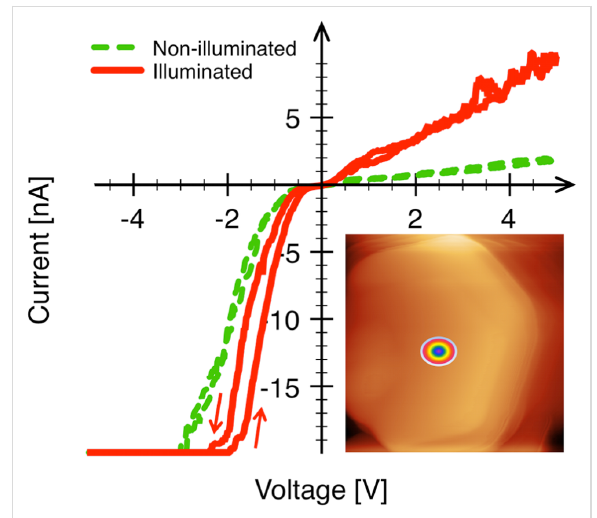
Figure 3: Current–voltage characteristics of dark (green curve, dashed) and illuminated state (red curve, solid) recorded from a single upright-standing ZnO nanorod by using a standard ±20 nA range amplifier. The illuminated characteristic was recorded by shining white light (150 W Xe lamp) at an angle of ca. 15–20° onto the sample. The arrows at the bottom indicate the direction of the voltage